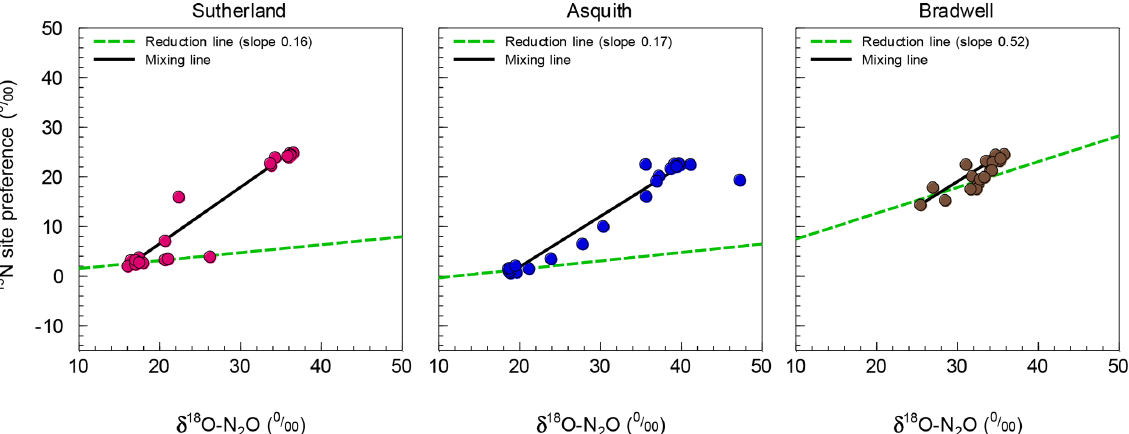
Figure 3. Isotopomer map to determine the source partitioning of N 2 O derived from nitrification versus denitrification using mean ( n = 4) 15 N site preference (SP) and δ 18 O of N 2 O. The linear mixed model approach was based on Deppe et al. (2017) and Lewicka-Szczebak et al. (2017), but with mixing line endmembers and reduction line slopes derived from our